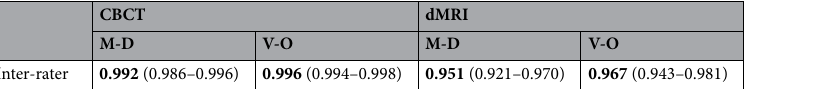
Table 2. Inter-rater ICC and 95% confidence interval of CBCT and dMRI canal length measurements in the mesio-distal (M-D) and vestibulo-oral (V-O) directions. Significant values are in bold.